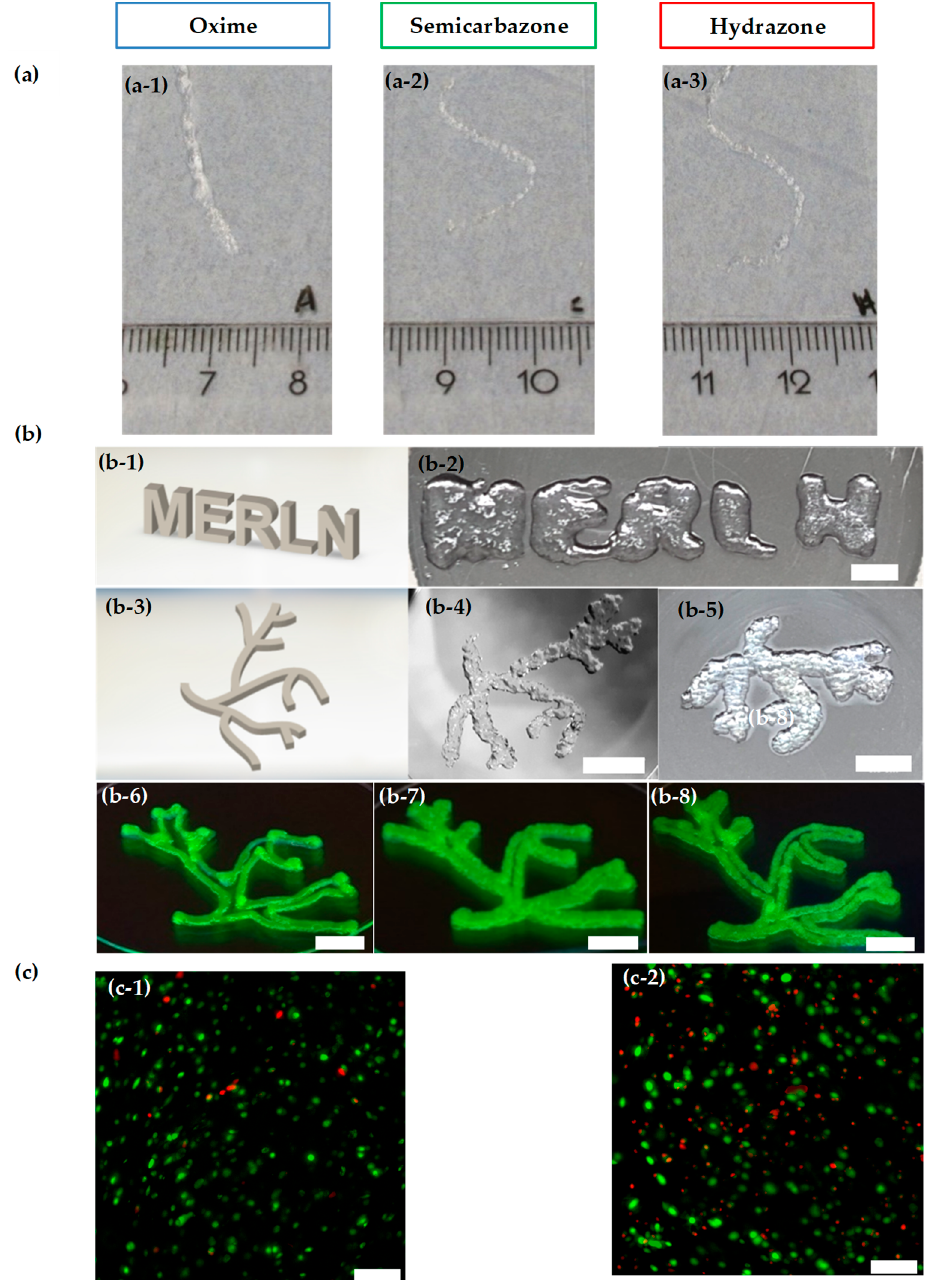
Figure 6. Injectability and bioprintability: ( a ) 10% ox-alg gels with oxime ( a-1 ), semicarbazone ( a-2 ), and hydrazone ( a-3 ) cross-linkers were extruded through a 25G needle. Semicarbazone and hydrazone showed injectability, and to our surprise oxime gels were also injectable, although they were not self-healing. ( b ) Printed MERLN and vascular tree structures using hydrazone crosslinks; 2% ( w / v ) of the 10% ox-alg used for ( b-2 – b-6 ) and 3% ( w / v ) and 4% ( w / v ) of 5% ox-alg used for ( b-7 ) and ( b-8 ), respectively. From the top left: 3D model of MERLN structure ( b-1 ), printed MERLN structure ( b-2 , 6 mm thickness), 3D model of vascular tree ( b-3 ), printed vascular tree ( b-4 , 2 mm thickness), printed vascular tree ( b-5 , 6 mm thickness), printed vascular tree ( b-6 – b-8 ) where the network was manually disrupted (fluorescein included for visibility), scale bar: 5 mm. ( c ) 10% ox-alg hydrazone gels after 24 h, ( c-1 ): Without printing and ( c-2 ): After bioprinting. Green color represents live cells and red color represents dead cells, Scale bar: 200 µ